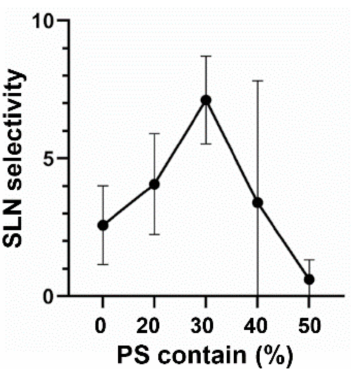
Figure 2. The effect of each main factor (Phospholipid, Cholesterol, PEG amount, Pore size, HAase treatment) on SLN selectivity. The number of each data set was 8. Circles and bars indicate each data point and mean.